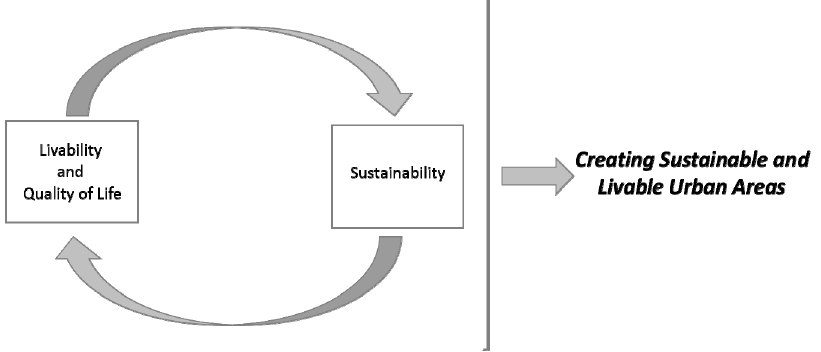
Figure 3. Relation among Modern Urban Areas, Sustainability, Quality of life, and Livability [Authors].